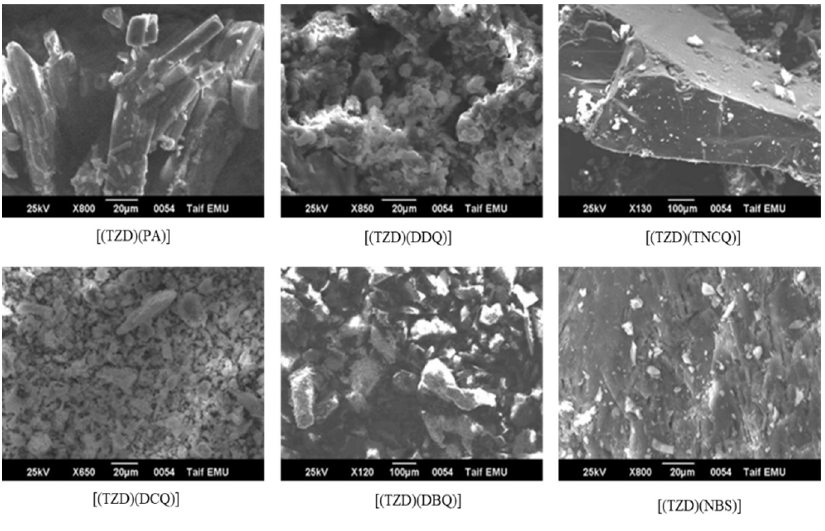
Figure 8. SEM images of the TZD with the six π